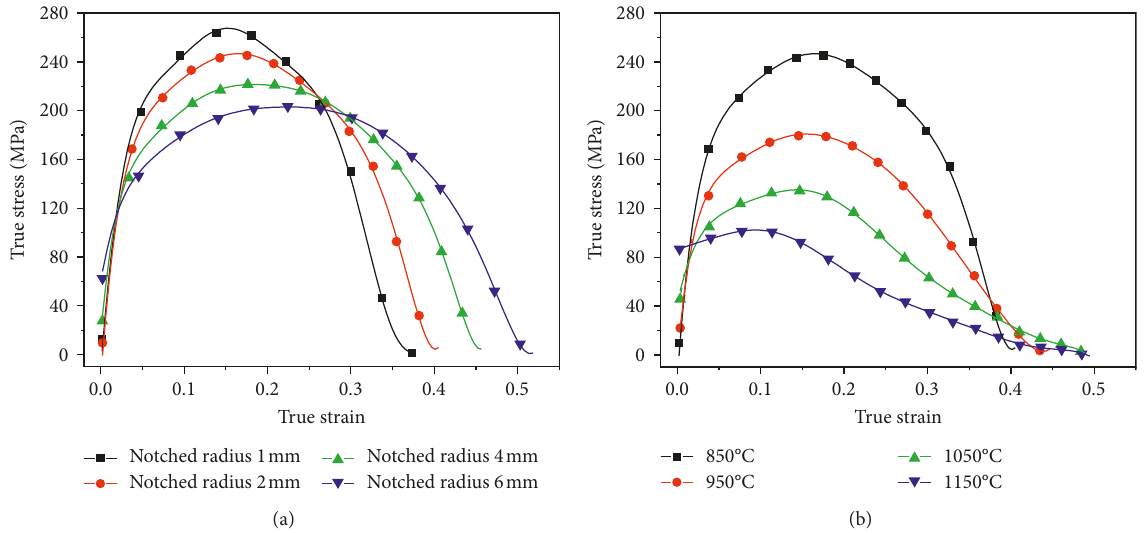
Figure 9: The true stress-strain curve of 35CrMo steel under different strain conditions: (a) 850 ° C; (b) notched radius 2